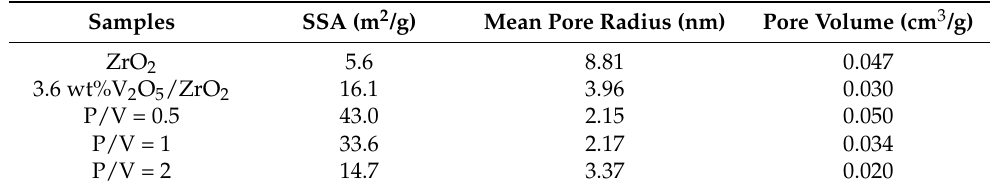
Table 1. Specific surface area SSA (m 2 /g) of ZrO 2 , 3.6 wt%V 2 O 5 /ZrO 2 and P loaded samples at different P/V